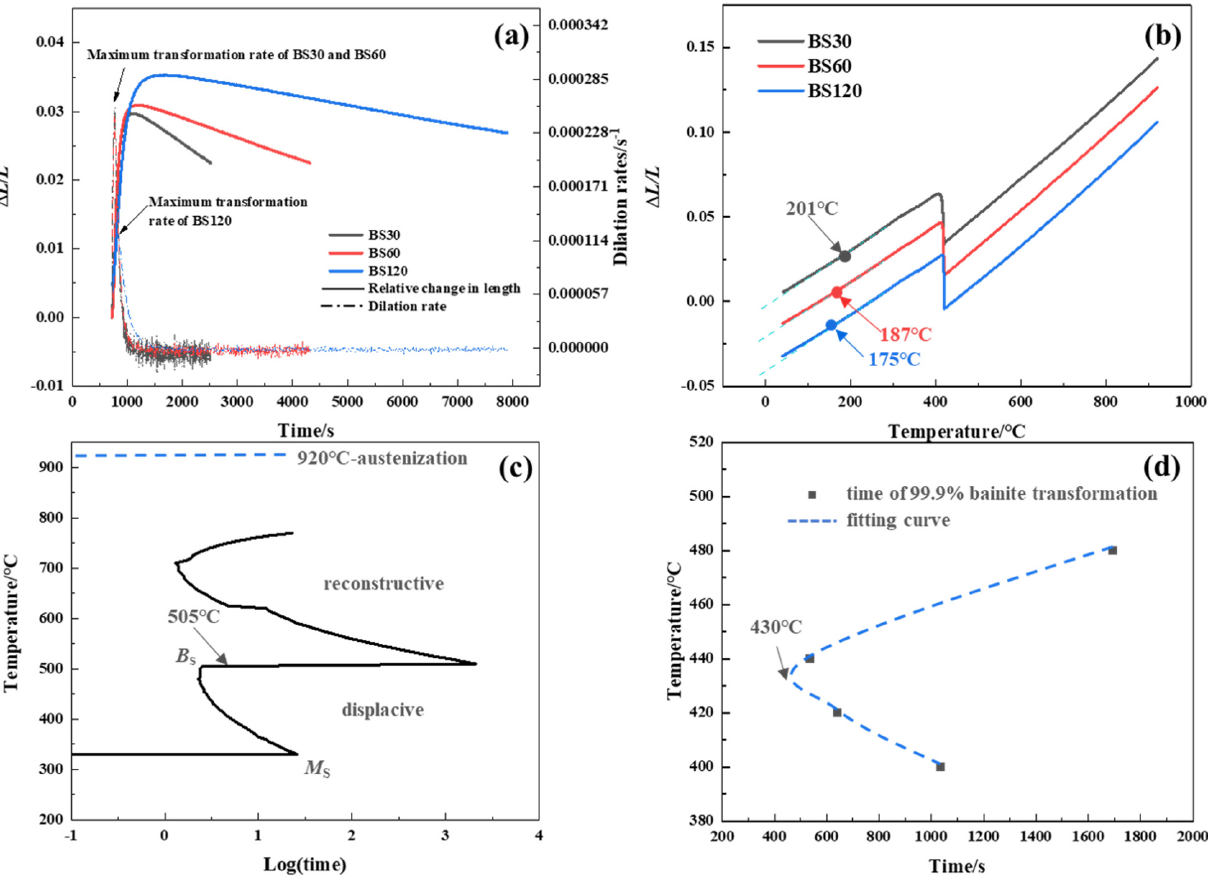
Figure 3. ( a ) The curves of the relative change of length and the dilation rate as a function of time during the slow cooling process; ( b ) the relative change of length as a function of temperature during the process of cooling to ambient temperature; ( c ) TTT diagrams calculated by the MUCG83 thermodynamic model; ( d ) the time and temperature curve for 99.9% of the bainite transformation measured with a dilatometer.